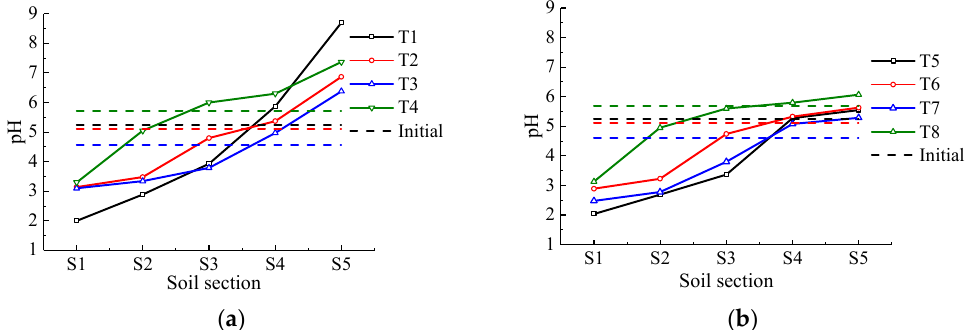
Figure 4. Changes of soil pH in different sections after electrokinetic remediation. ( a ) EK Remediation; ( b ) EK-PRB Remediation.